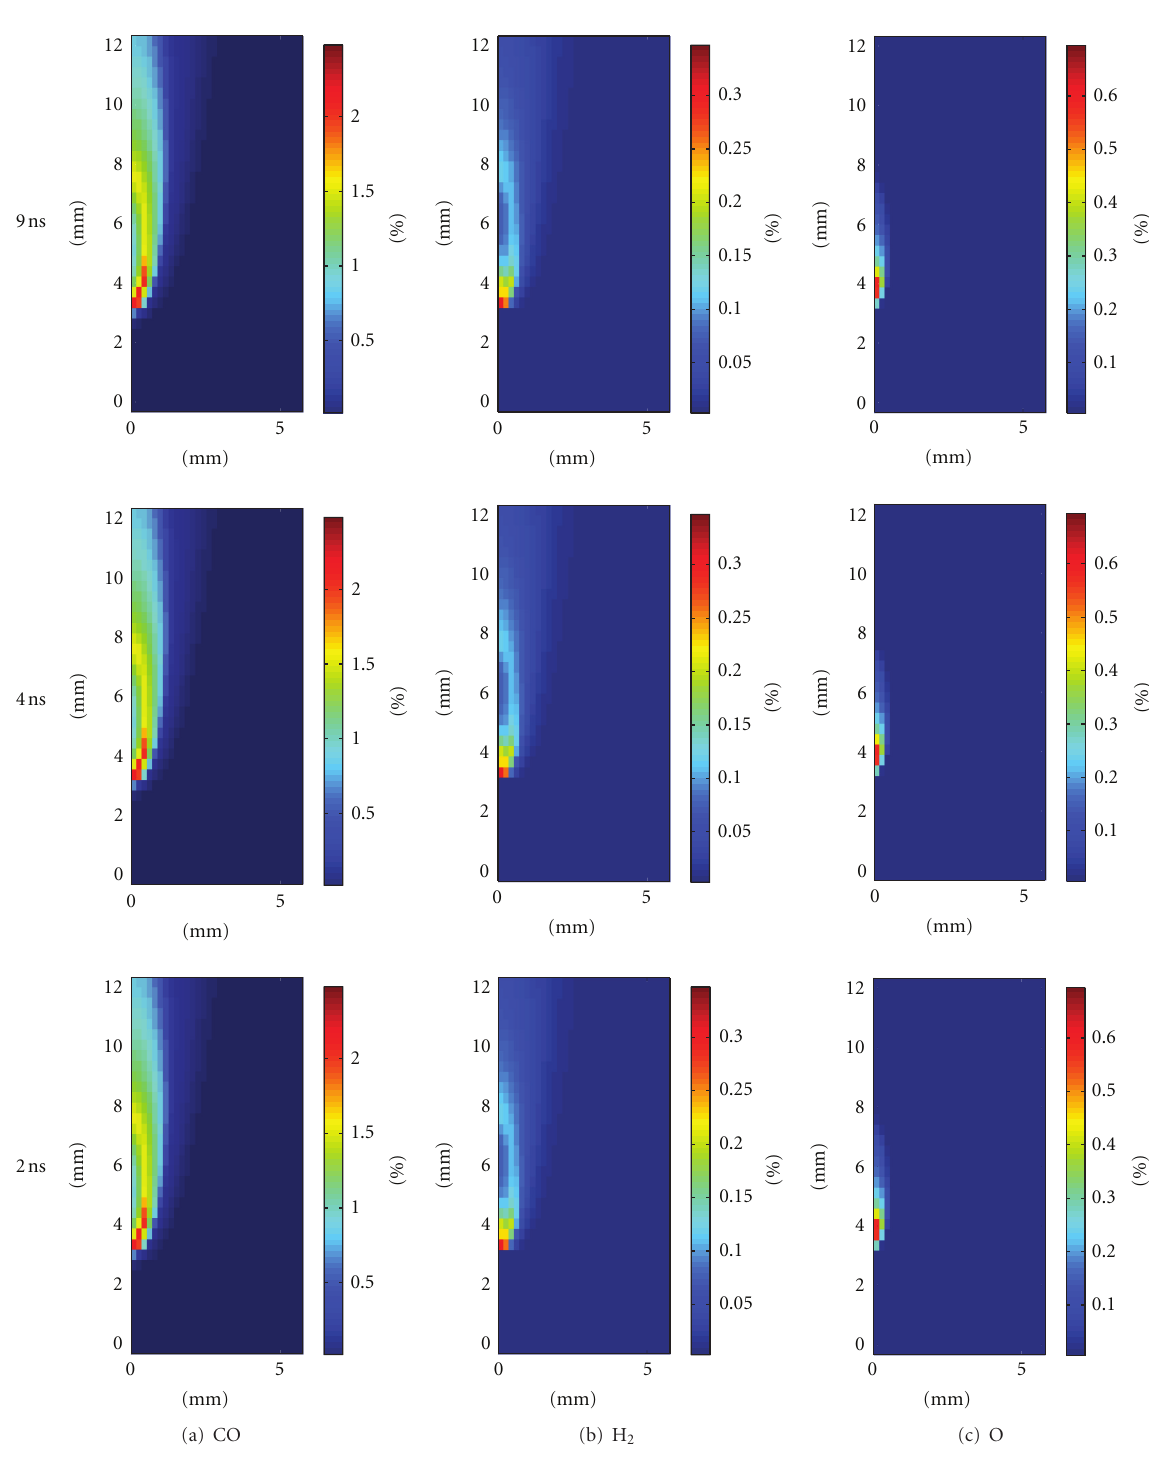
Figure 7: Quasi-steady state spatial distribution of (a) CO, (b) H 2 , and (c) O for three di ff erent pulse widths of 9 ns, 4ns, and 2ns at 30 kHz repetition